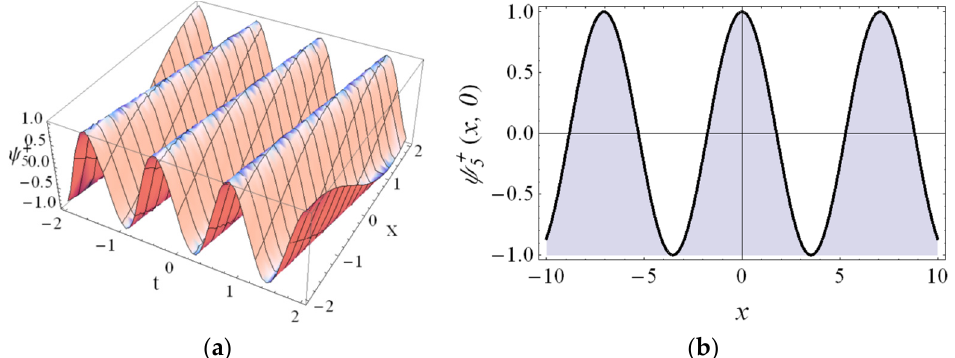
= 1, k = 1, c = 6. ( a ) 3-D plot, ( b ) 2-D ( x , t ) with A 5 5